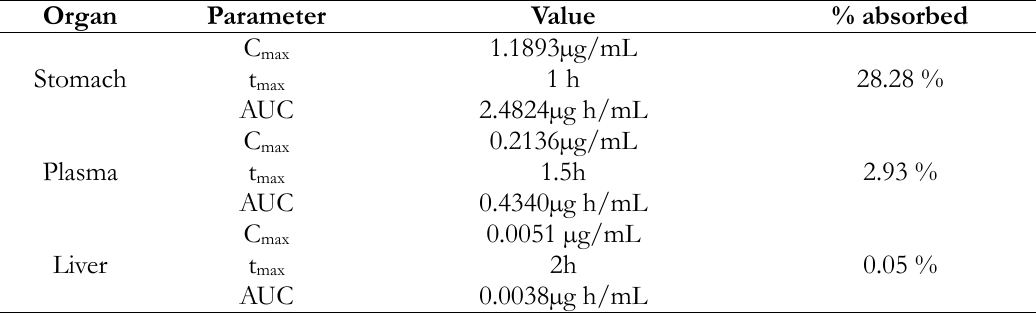
Table 2. Bioavailability parameters of sambiloto infusion calculated as andrographolide